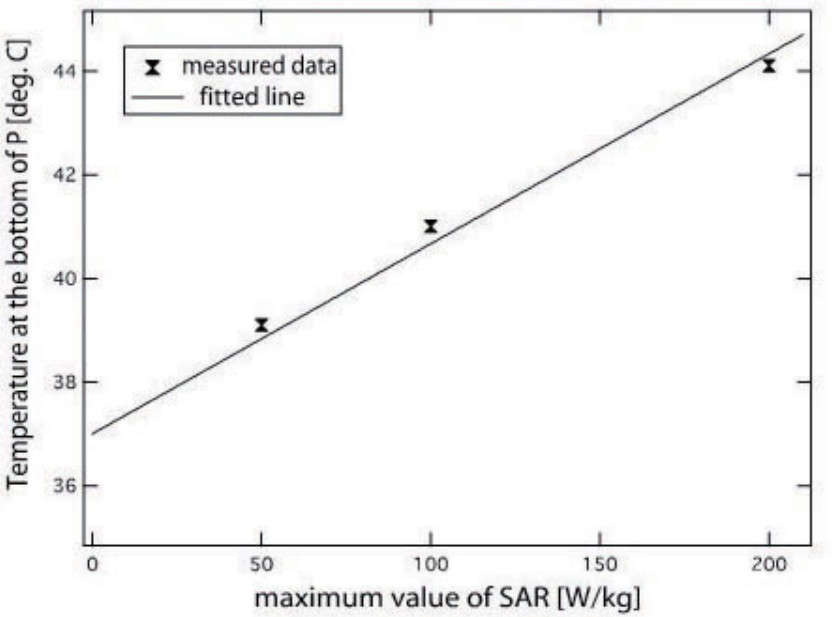
FIGURE 4. A graph of the temperature rising in the medium after 2000 sec from the onset of the exposure at the bottom of position P in Fig. 2(a).